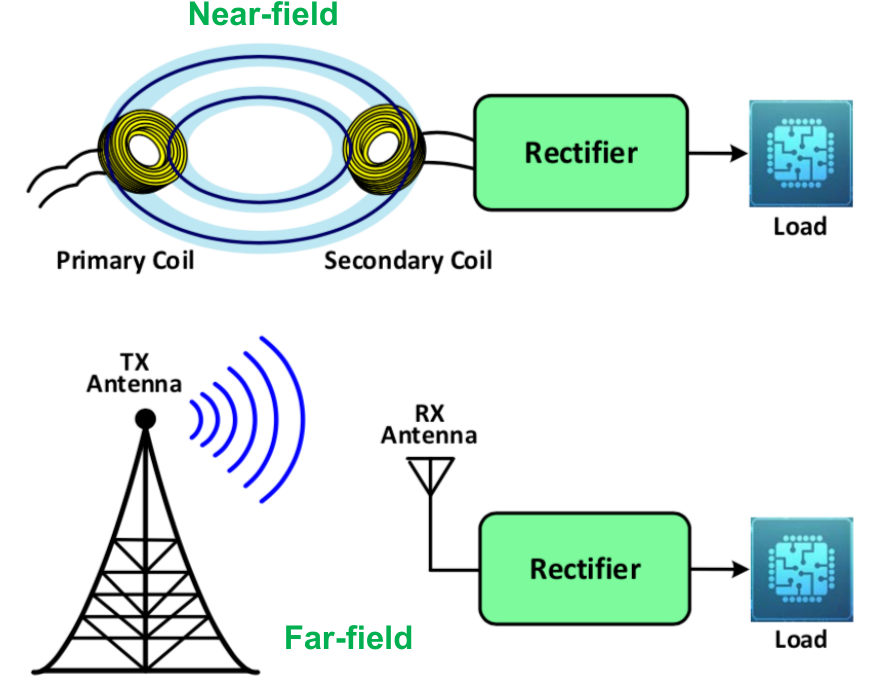
Figure 18. Wireless Power Transfer